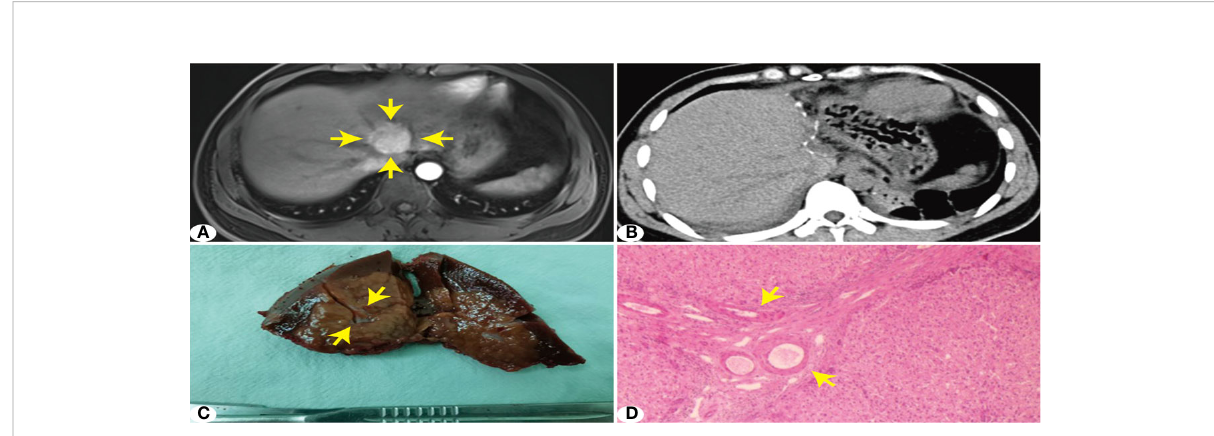
FIGURE 2 Surgical hepatectomy of S4 segment FNH lesions. (A) MRI arterial phase enhanched image. (B) Postoperative CT image. (C) FNH surgical resection of gross specimens (small spacimens are FNh lesions, and large specimens are the resction range of normal liver tissue. (D) Liver FNH microscope image.